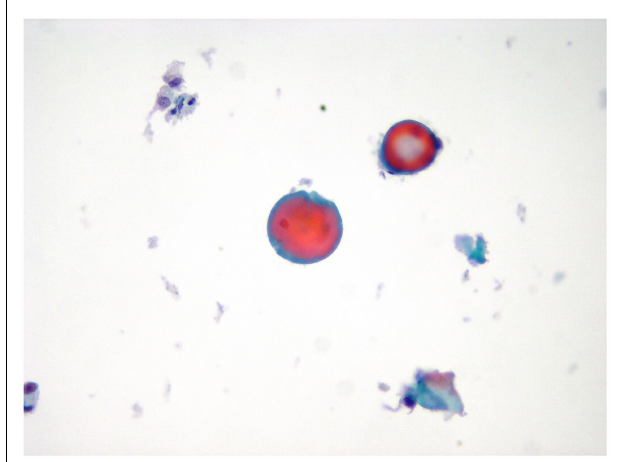
FIGURE 1 |A case of colloid goiter exhibiting small clusters of monomorphic follicular cells mixed with colloid droplets (LBC, Papanicolaou, 400 ×